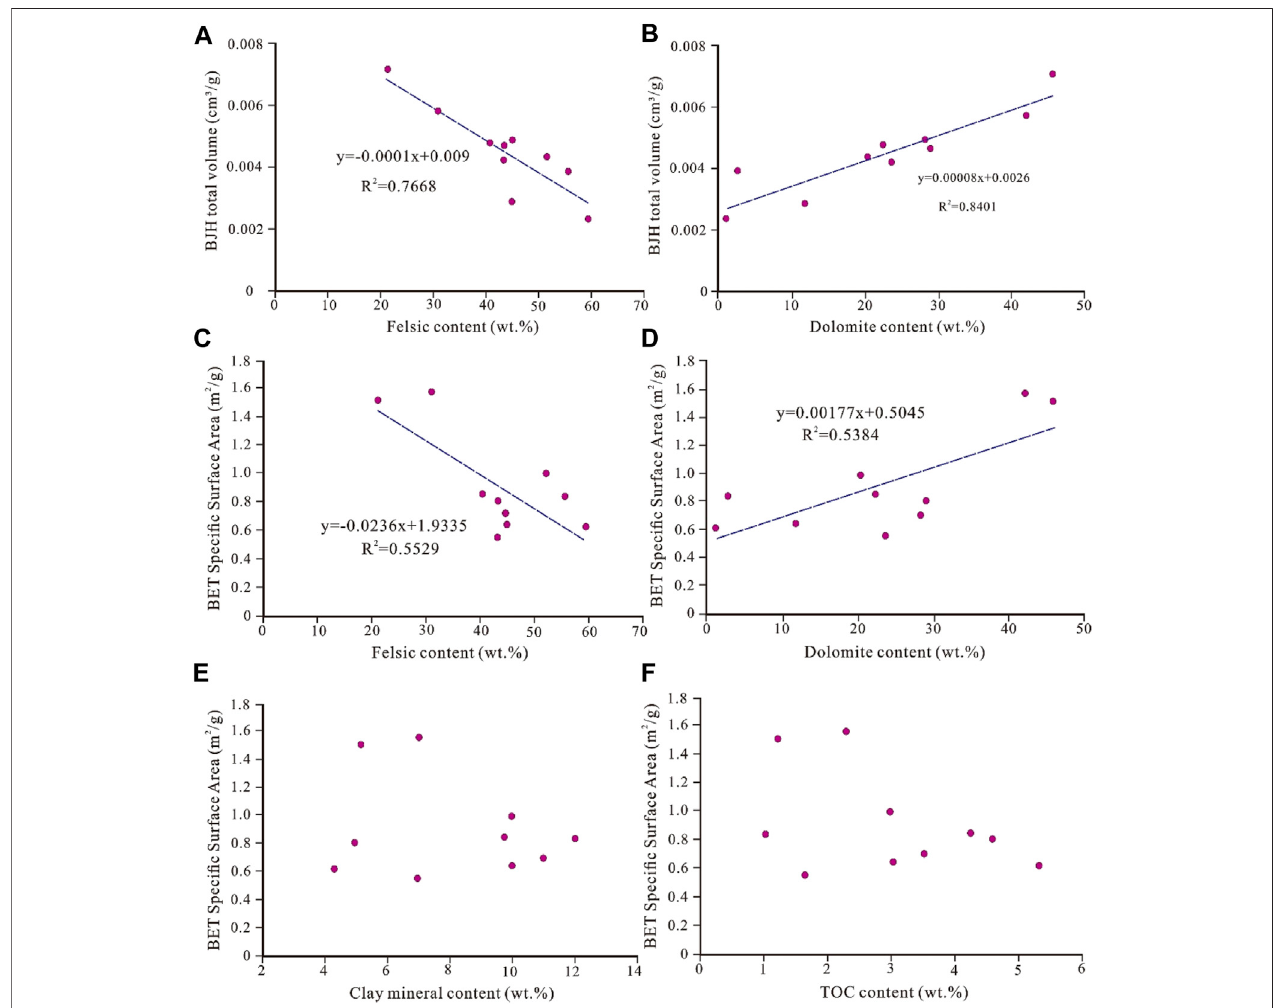
FIGURE 10 | The scatter diagrams and extrapolated correlations for different pore structure parameters vs organic matter and mineral compositions.